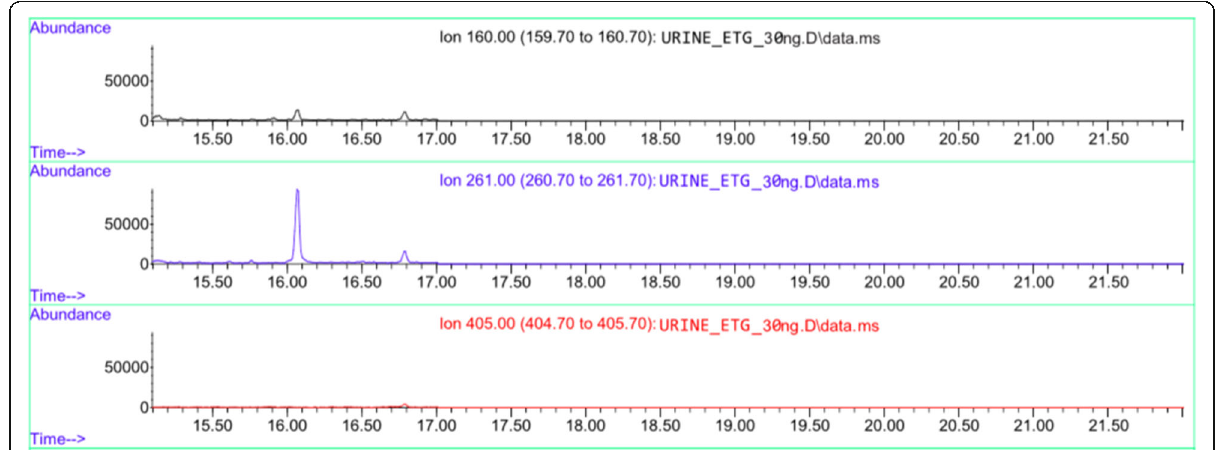
Fig. 4 Reconstructed ion chromatogram of 30 ng/ml